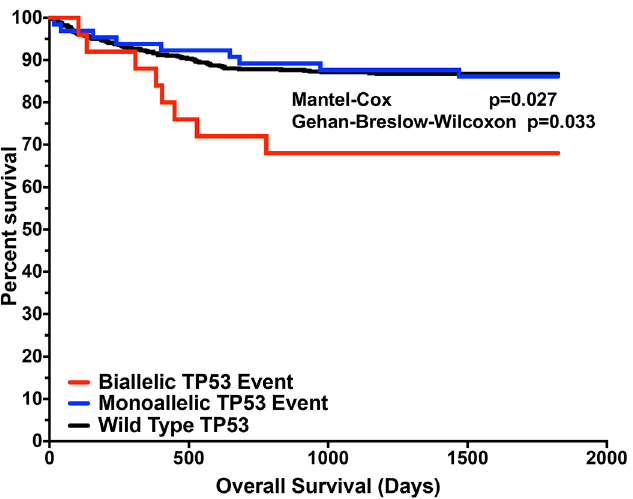
Fig 5. Overall survival of patients based upon TP53 locus alterations. (A) Kaplan-Meier analysiswith long-ranktest for overall survival data from CoMMpass IA9 cases stratified by mono-allelic (blue) versus bi- allelic(red) alterationas well as wildtype(black) of the TP53